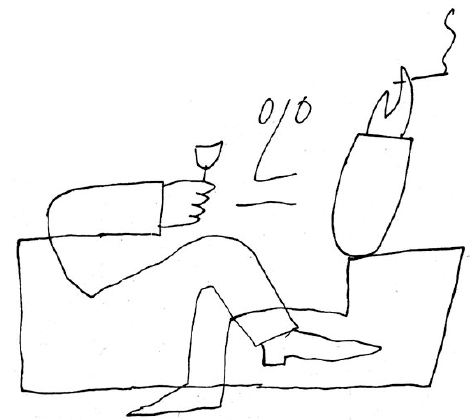
Figure 12. S. Steinberg , Drawing from The Passport ,